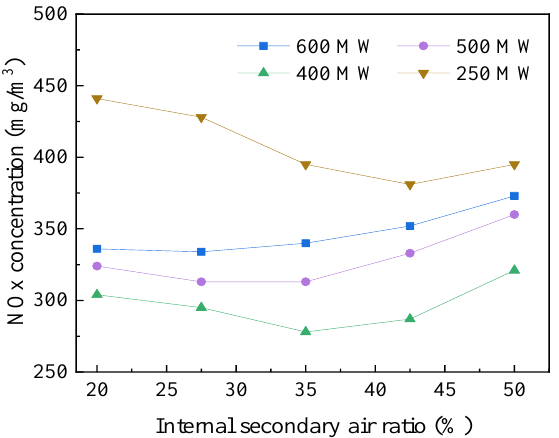
Figure 16. Variation in NOx concentration at economizer outlet with the internal secondary air ratio. Effects of Internal Secondary Air Ratio on NOx Distribution in